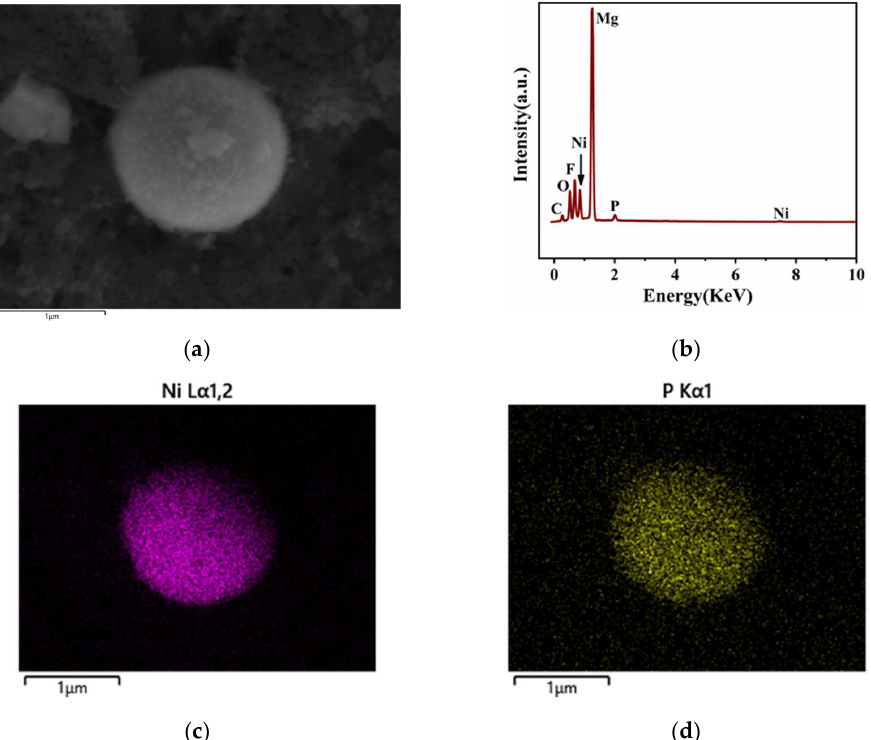
Figure 3. ( a ) The surface morphology images of the Mg–Li alloy at 2 min into the deposition reaction; ( b ) EDS spectrum of Mg–Li alloy at 2 min into the deposition reaction; ( c , d ) element mapping of Mg–Li alloy at 2 min into the deposition reaction.